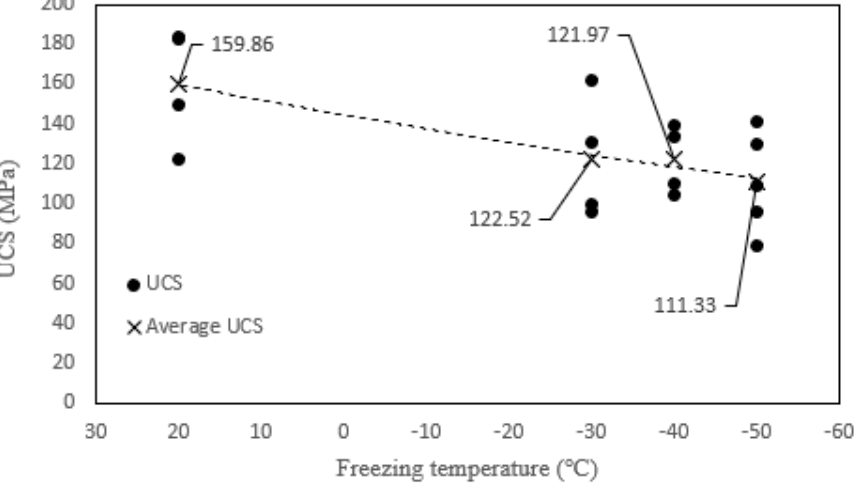
Figure 4. The variation of uniaxial compressive strength (UCS) for tonalite subjected to freeze-thaw cycles (G1 and G3).